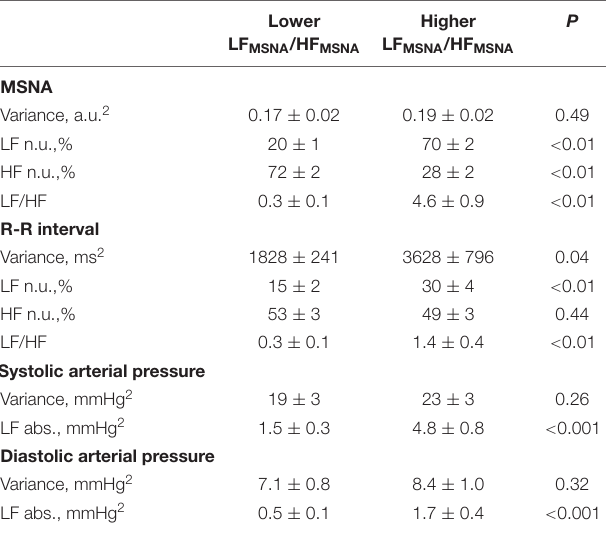
TABLE 2 | Spectral parameters of MSNA, RR-interval, SAP, and DAP of HFrEF patients with lower and higher oscillatory pattern of MSNA.